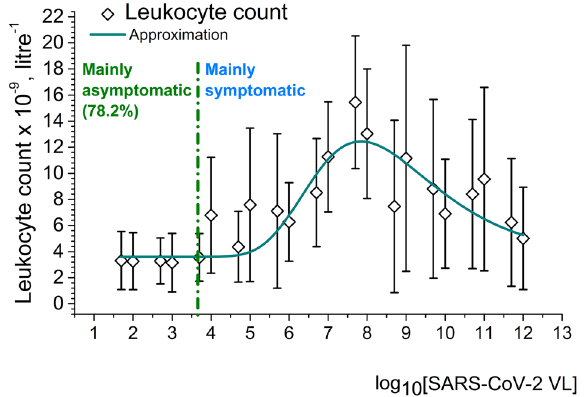
Figure 2. Correlation between leukocyte count in serum on logarithm of SARS-CoV-2 VL. Created in OriginPro ver. 9.2.196, https:// www. origi nlab.